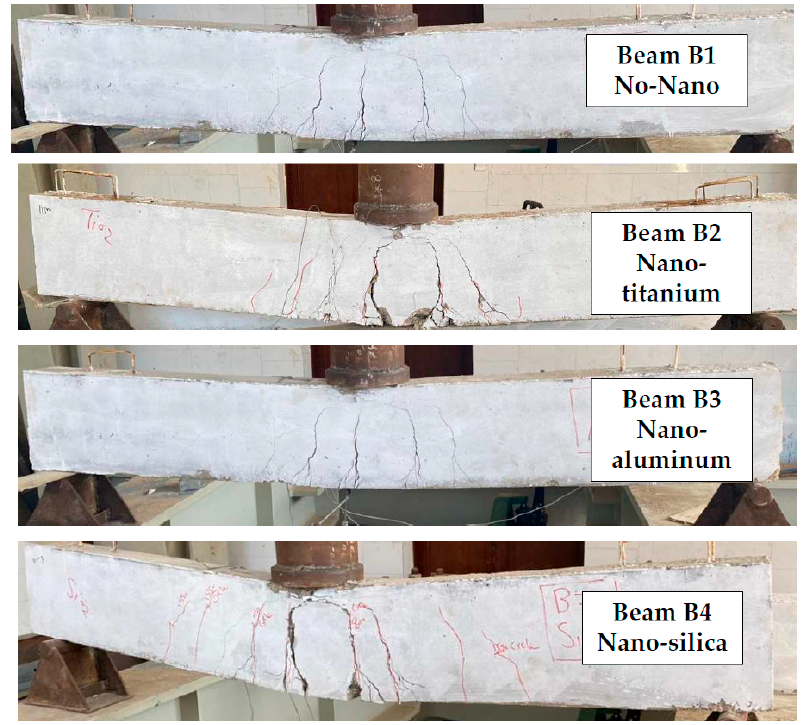
Figure 8. Failure modes for the tested RC beams subjected to cyclic loading.